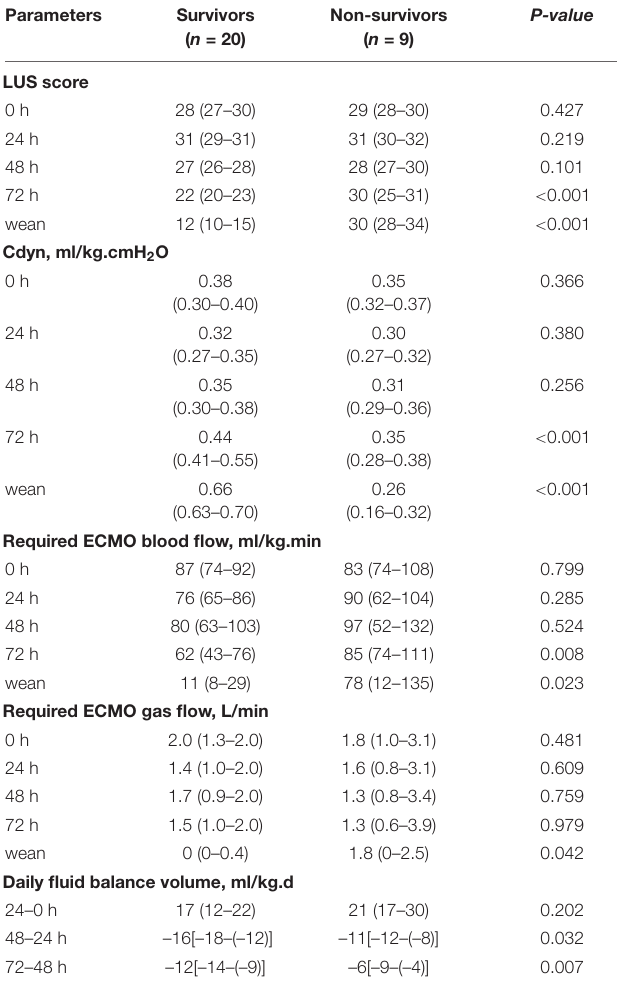
TABLE 2 | Comparison of LUS score, respiratory compliance, and daily fluid balance during ECMO between survivors and non-survivors (IQR).